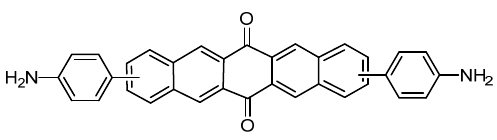
Figure 2. The environmental synthesis of 1,2-disubstituted benzimidazoles by microwave irradia- tion and Er(OTf) 3 .